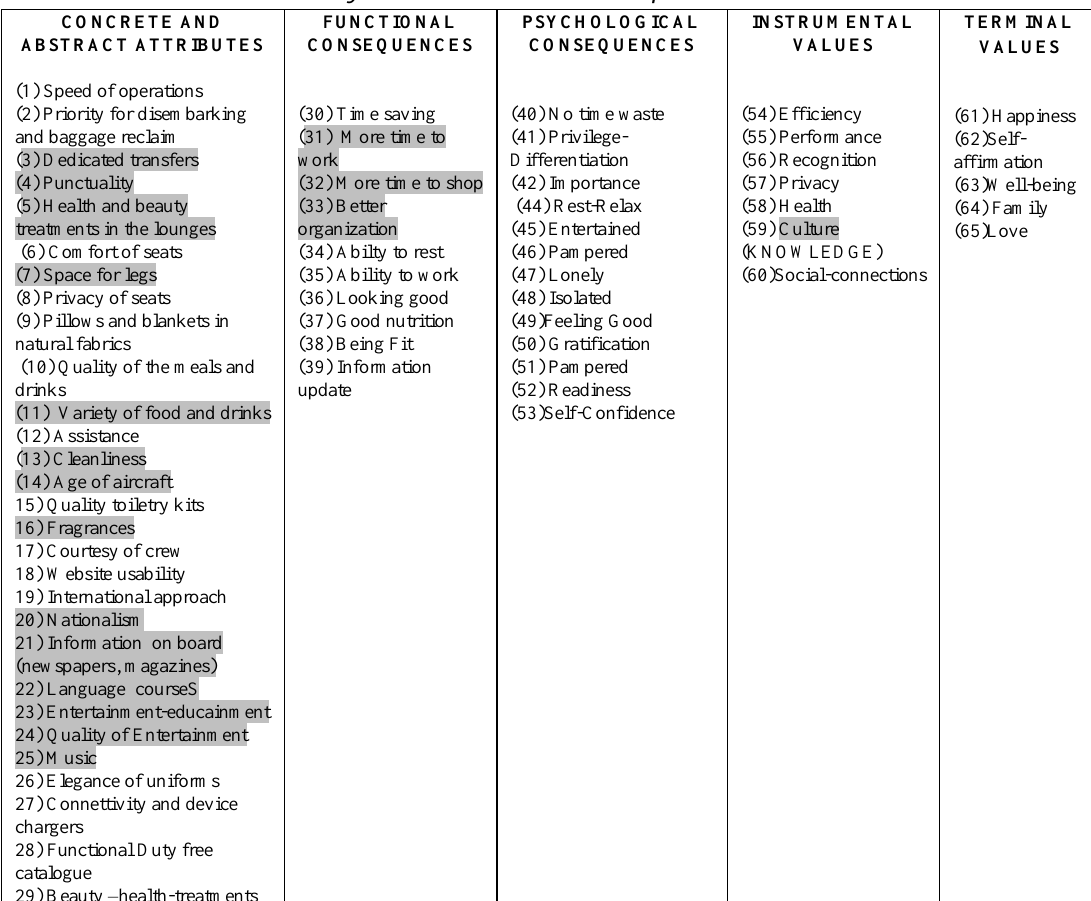
Table 1: First Wave Analysis : Attributes – Consequences –